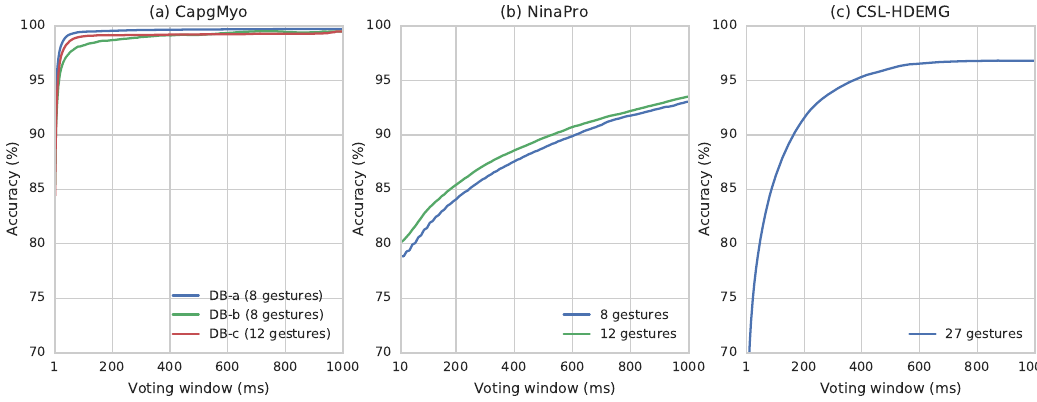
Figure 6. Surface EMG gesture recognition accuracy with different voting windows using ConvNet. ( a ) Recognition accuracy of gestures in CapgMyo; ( b ) Recognition accuracy of two subsets of gestures in NinaPro DB1; ( c ) Recognition accuracy of 27 gestures in CSL-HDEMG (Reprinted from